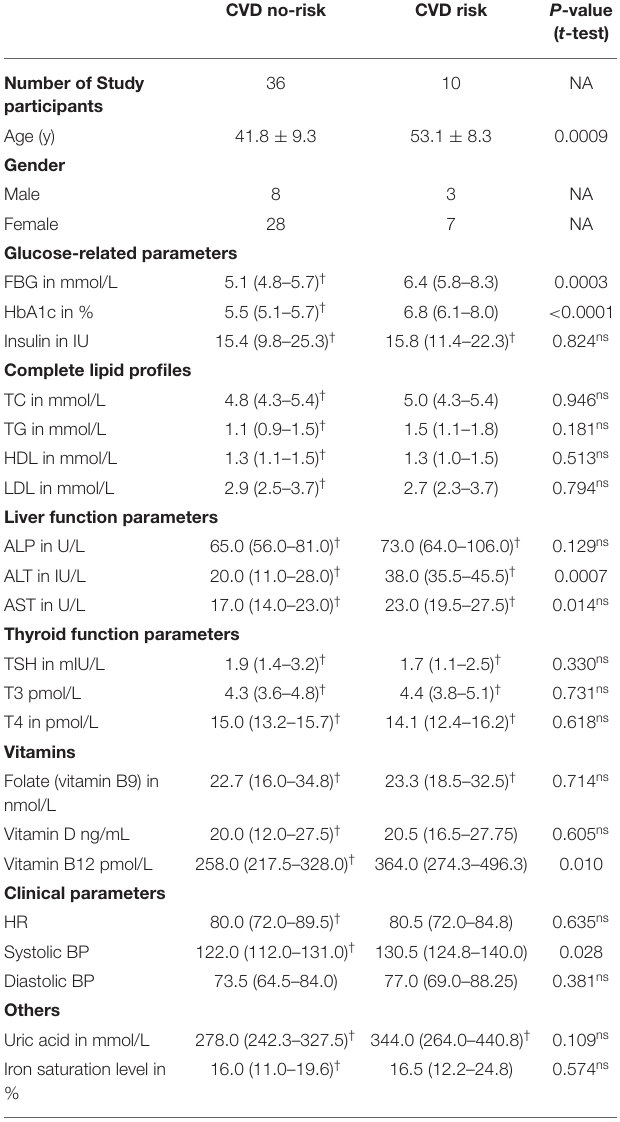
TABLE 1 | Demographic, clinical, and biochemical parameters of the study participants. CVD